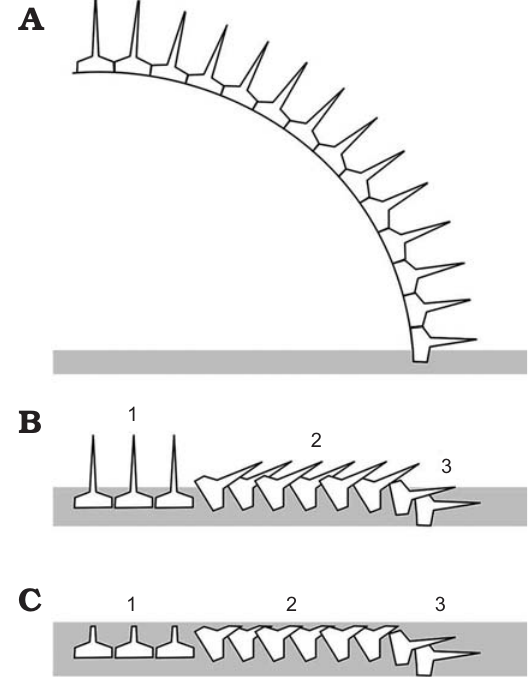
Fig. 7. Interpretation of taphonomy of the diploporite blastozoan Lepido- calix pulcher . A . Original disposition of partial theca still articulated. B . Positions of isolated plates after decay of ligaments and possible accu- mulation of a little more sediment (grey). Three areas can be